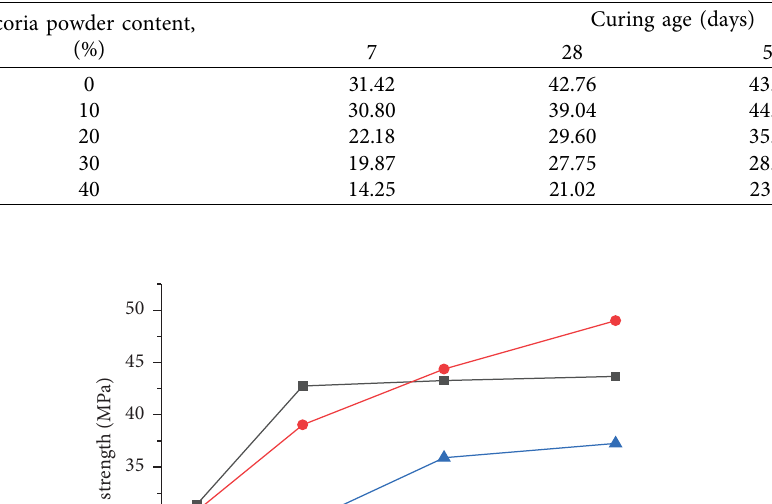
Table 8: Mean compressive strength results (MPa) with diferent scoria content.